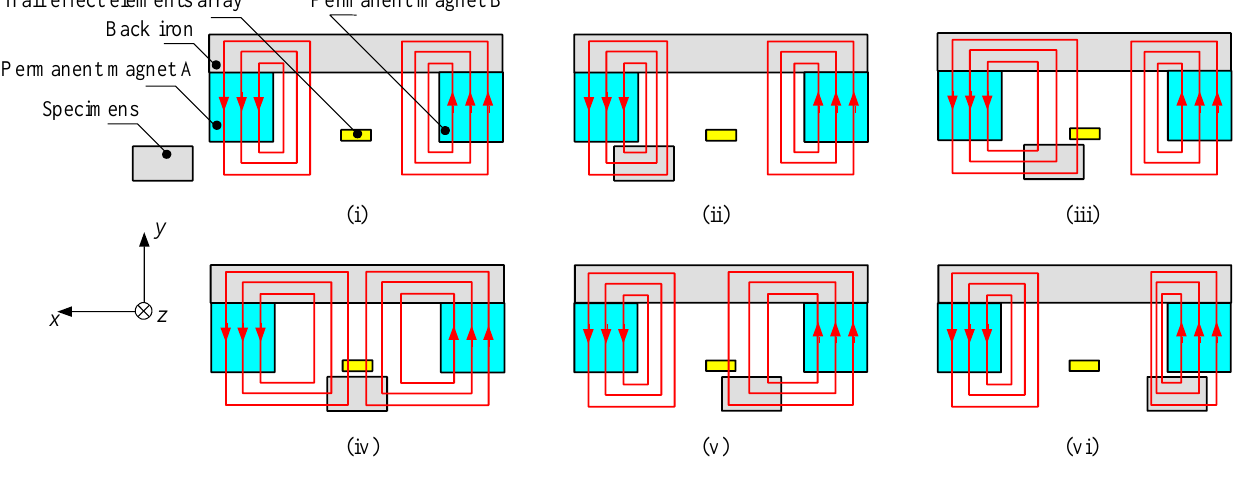
Figure 1. Structure and basic principle of the Hall Sensor